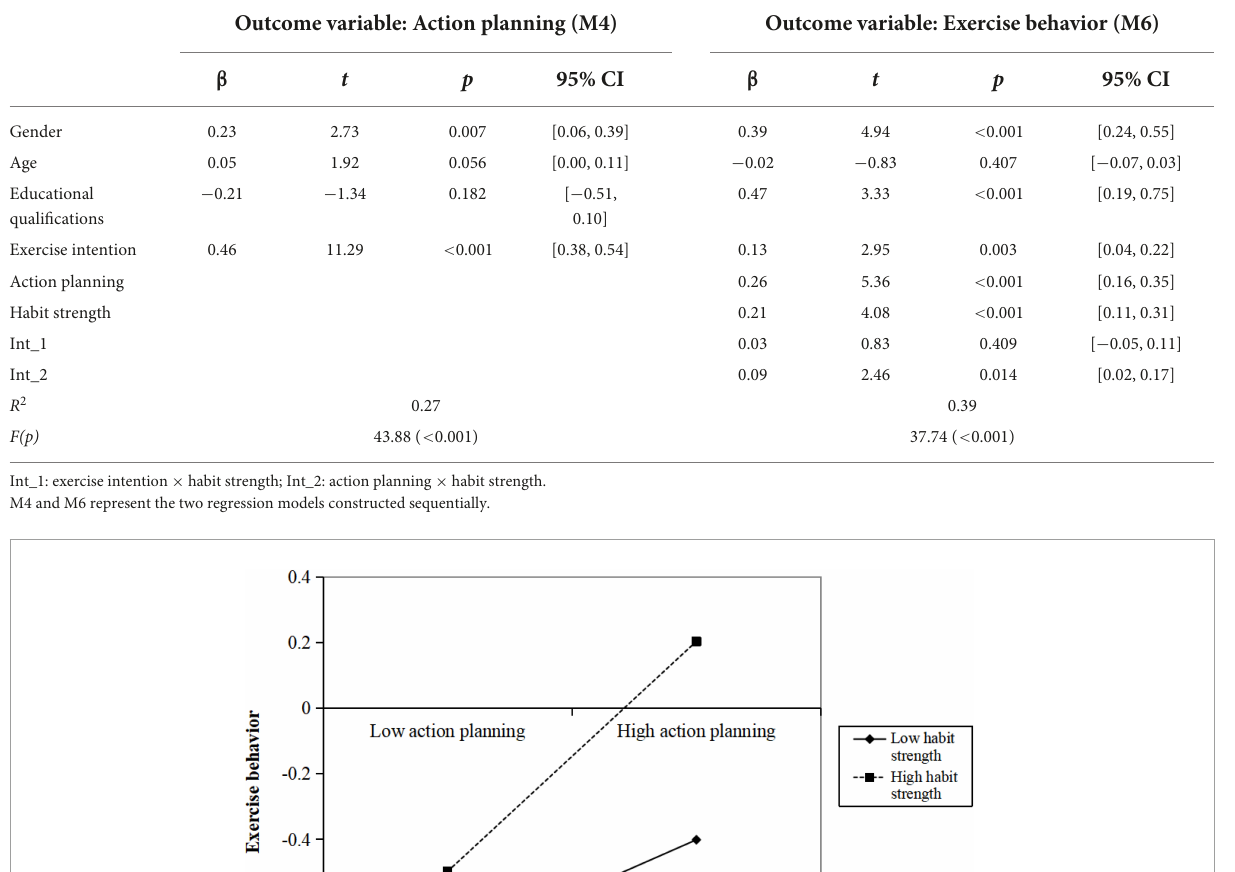
TABLE 5 Results of the test for moderating effects of habit strength.